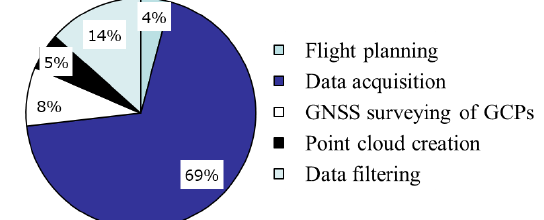
Figure 8. Ratio of a cost of each work in ordinary ALS